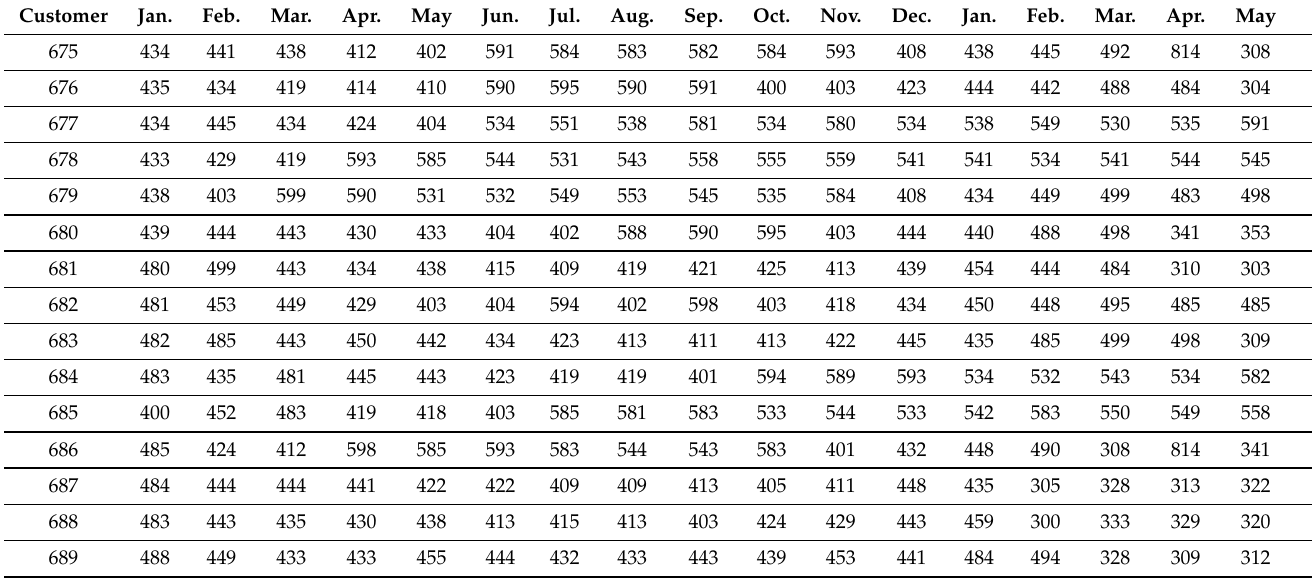
Table 1. Some of the original monthly power consumption (kWh) data of microgrid